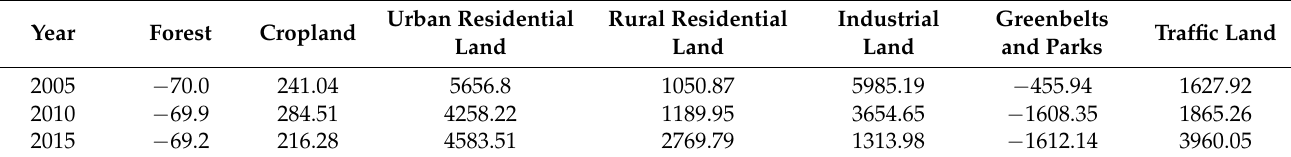
Table 1. Nitrogen intensities of source and sink landscapes (kg/ha).